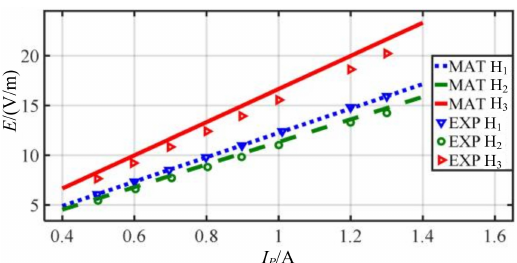
Figure 14. Electric field intensity at different h 1 values